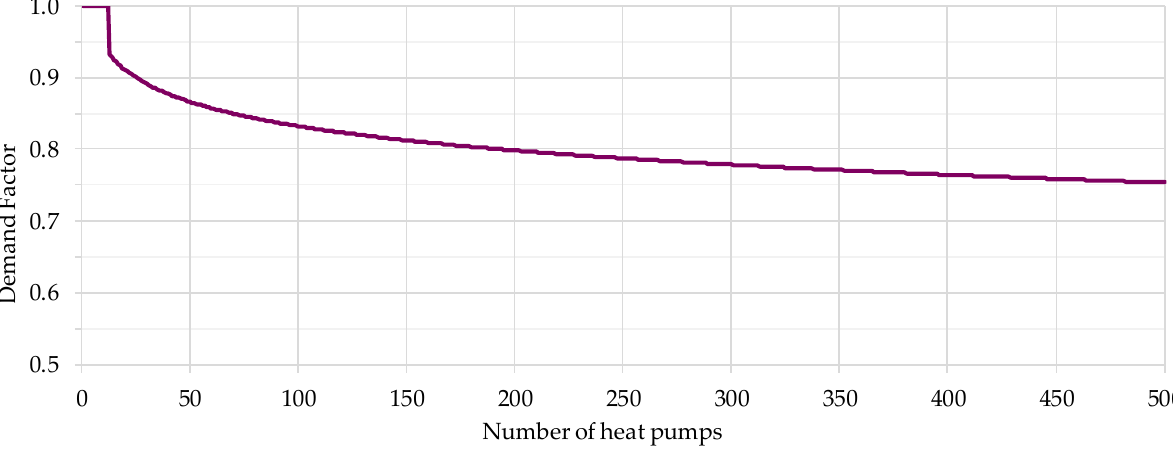
Figure 3. Demand factors for up to 500 heat pumps based on [51].